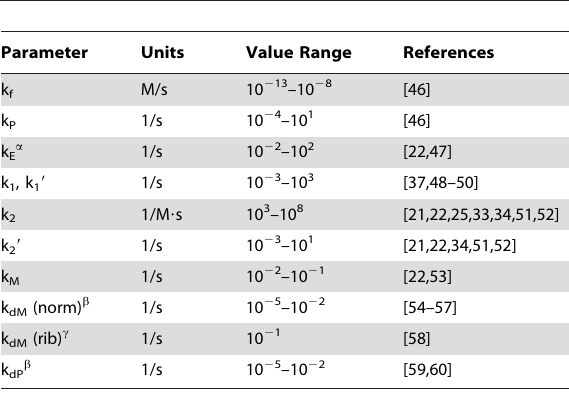
Rates for endogenous mRNA degradation (norm) and ribozyme cleavage (rib) are separately described. a Reflects the time to reach the termination stem following transcription initiation and is dependent on the rate of polymerase extension, pausing, the length of the transcribed sequence, and nucleotide concentration. b Includes mRNA or protein degradation and dilution due to cell division.